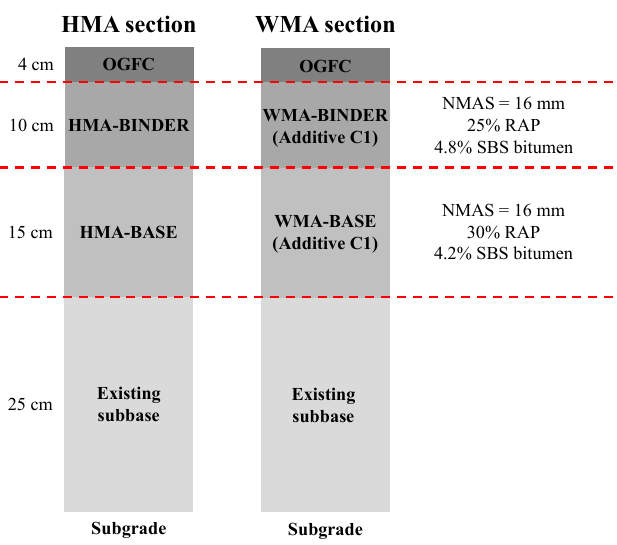
Figure 2. Cross-section of the HMA and WMA pavements.